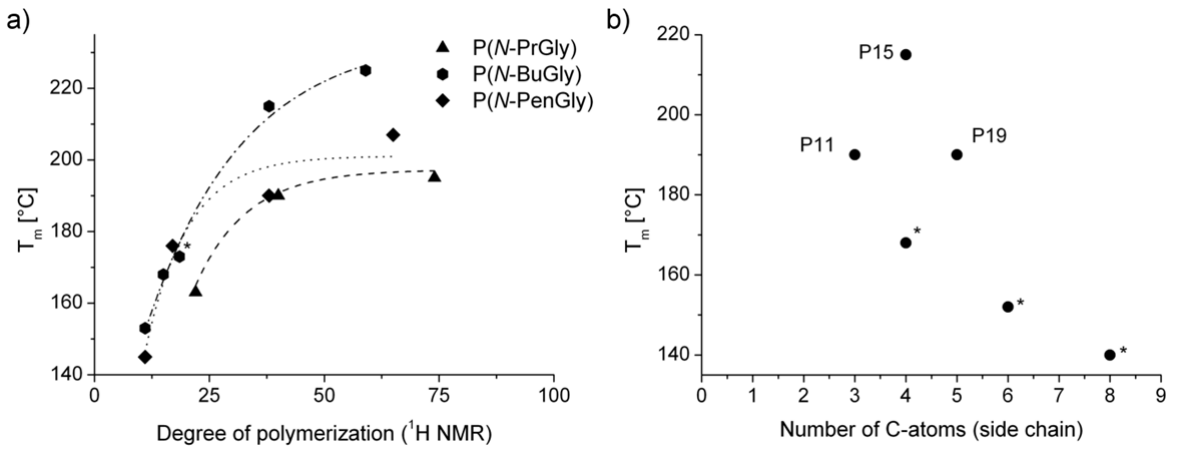
Figure 6. Comparison of polymer melting temperatures (T of polymerization and ( b ) the polymer side chain length. Please note, values marked with asterisks were obtained by graphical extraction from ref.[29] and represent polymers with a degree of polymerization of 15. Lines in ( a ) only serve as guide for the